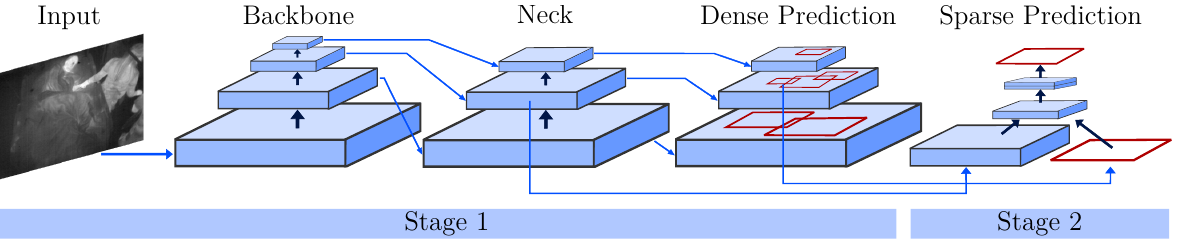
Figure 5. One- and two-stage object detectors modified from